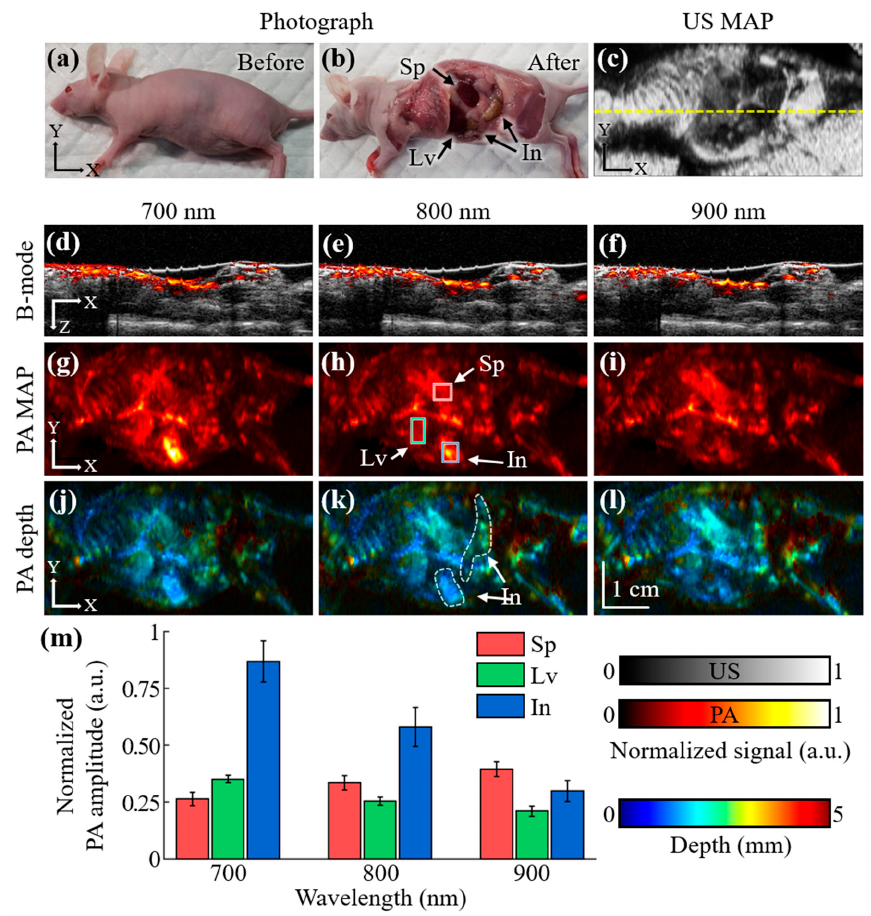
Figure 4. In vivo whole-body imaging of a mouse. ( a , b ) Photograph of the mouse before and after experiments. ( c ) US MAP images of the mouse after removing membrane signals. ( d – f ) Overlaid B-mode images of the mouse at the cross-sectional plane indicated as the yellow dashed line in ( c ). ( g – i ) PA MAP images of the mouse with excitation wavelengths of 700, 800, and 900 nm. ( j – l ) Depth-coded PA MAP images of the mouse. The white dashed lines represent the intestine at deep tissue, revealed with the depth-coded PA images. The depth of each pixel is calculated as the distance from the skin, which is determined from the corresponding US images. ( m ) Quantified PA signals at the ROIs depicted as colored rectangles in ( h ). Same ROIs are applied to the PA MAP images at each excitation wavelength. PA, photoacoustic; US, ultrasound; MAP, maximum amplitude projection; ROI, region of interest; Sp, spleen; In, intestine; Lv,